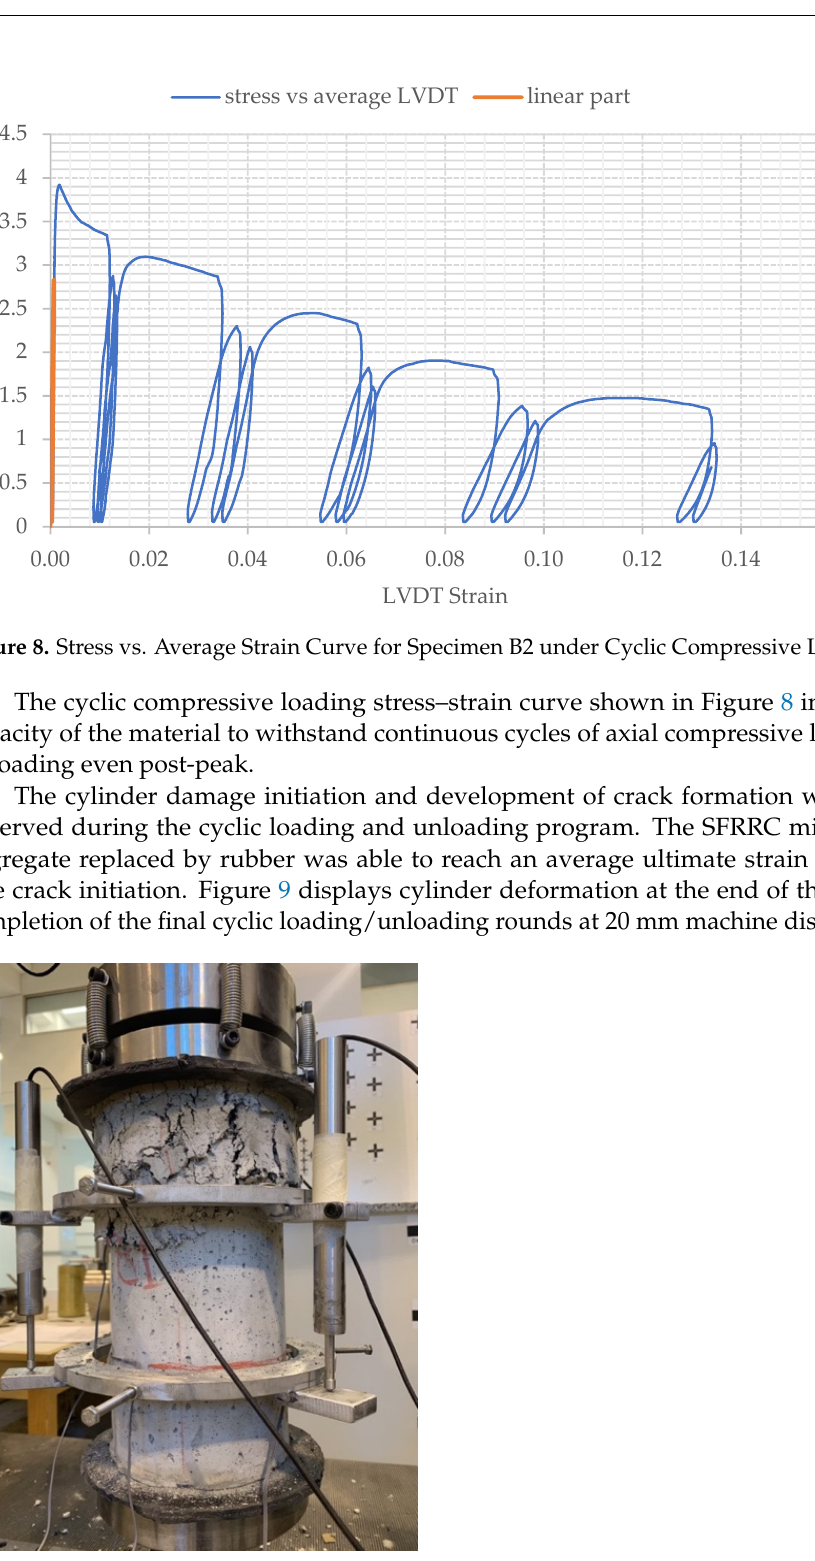
Figure 9. Cyclic Compressive Loading Specimen B1 at 20 mm Displacement.